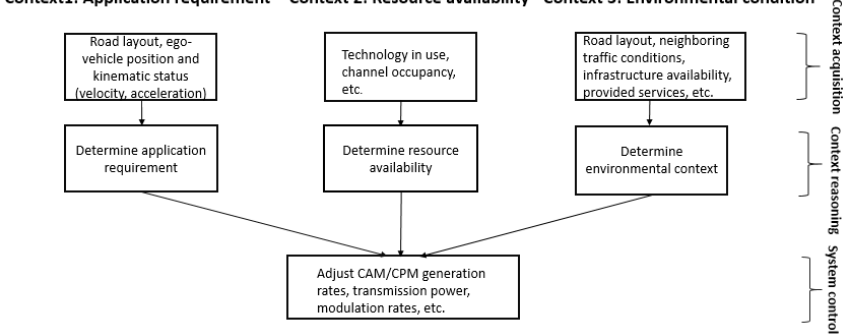
Figure 2. Context awareness for collision avoidance